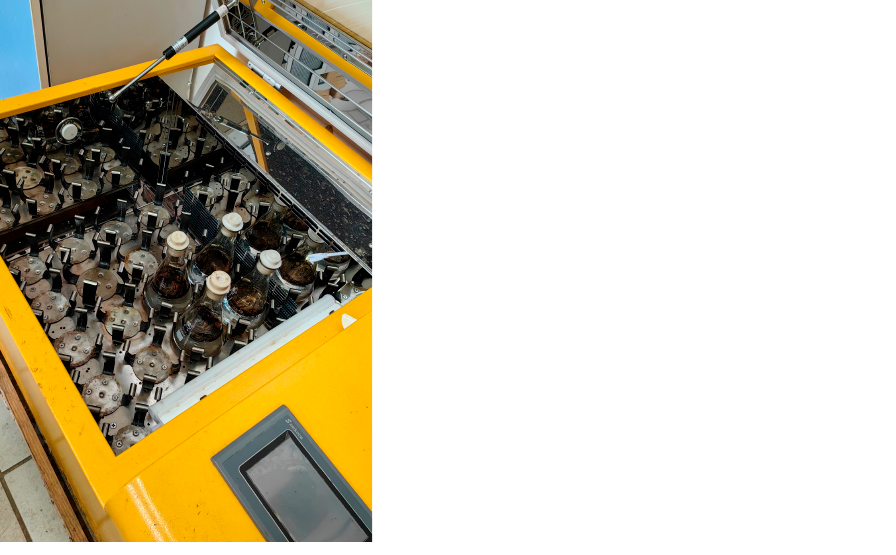
Figure 1. Photograph of the oscillating incubator with baffled conical flasks employed in the experiments. Table 2. Conditions and parameters for the laboratory experiments.